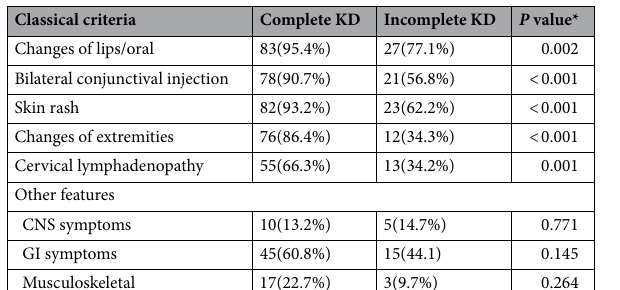
Table 1. Clinical findings in patients with complete and incomplete KD (* Chi squared test).